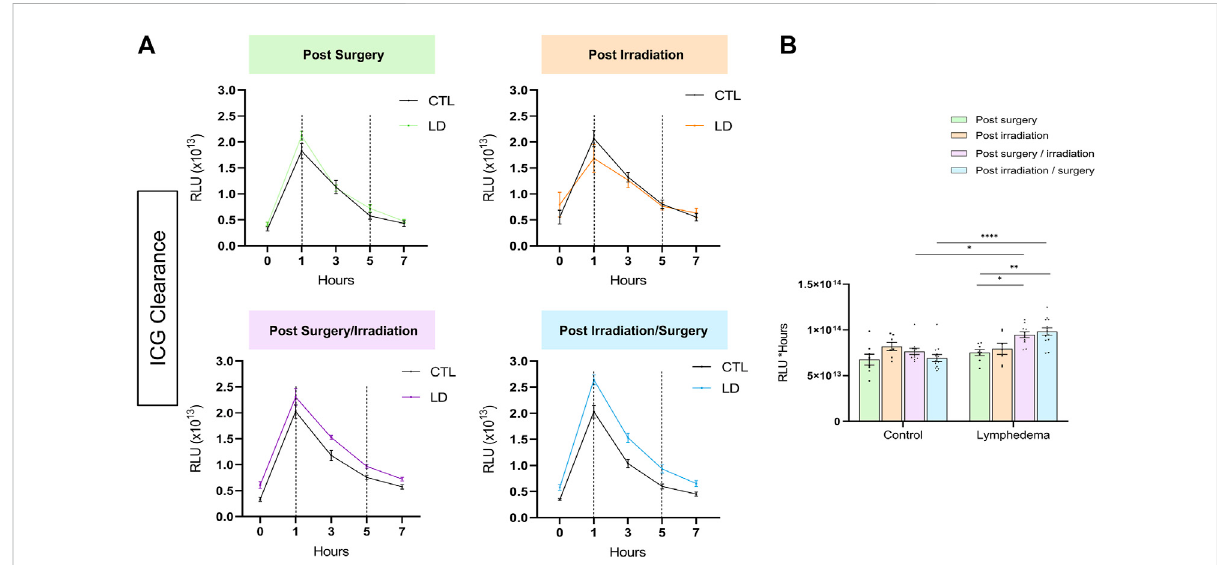
FIGURE 4 Tracking of ICG fl uorescence resorption over time in lymphedema. (A) ICG is accumulated in the LD of the post-Surgery/Irradiation and Irradiation/Surgery groups. (B) Comparison of areas under the curve between 1 h (onset of clearance) and 5 h between the different groups. (Statistical test: two-way ANOVA with multiple comparison Turkey ’ s test, p < 0.05: *, p < 0.01: **, p < 0.001: ***, p < 0.0001: